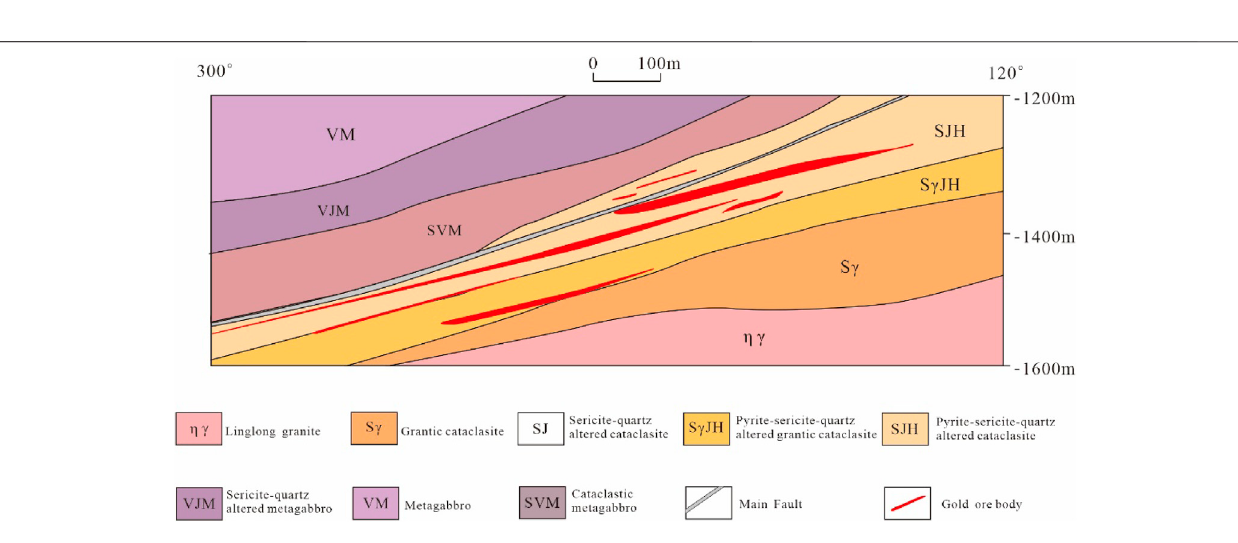
FIGURE 3 | Simpli fi ed cross-section of the Zhaoxian gold